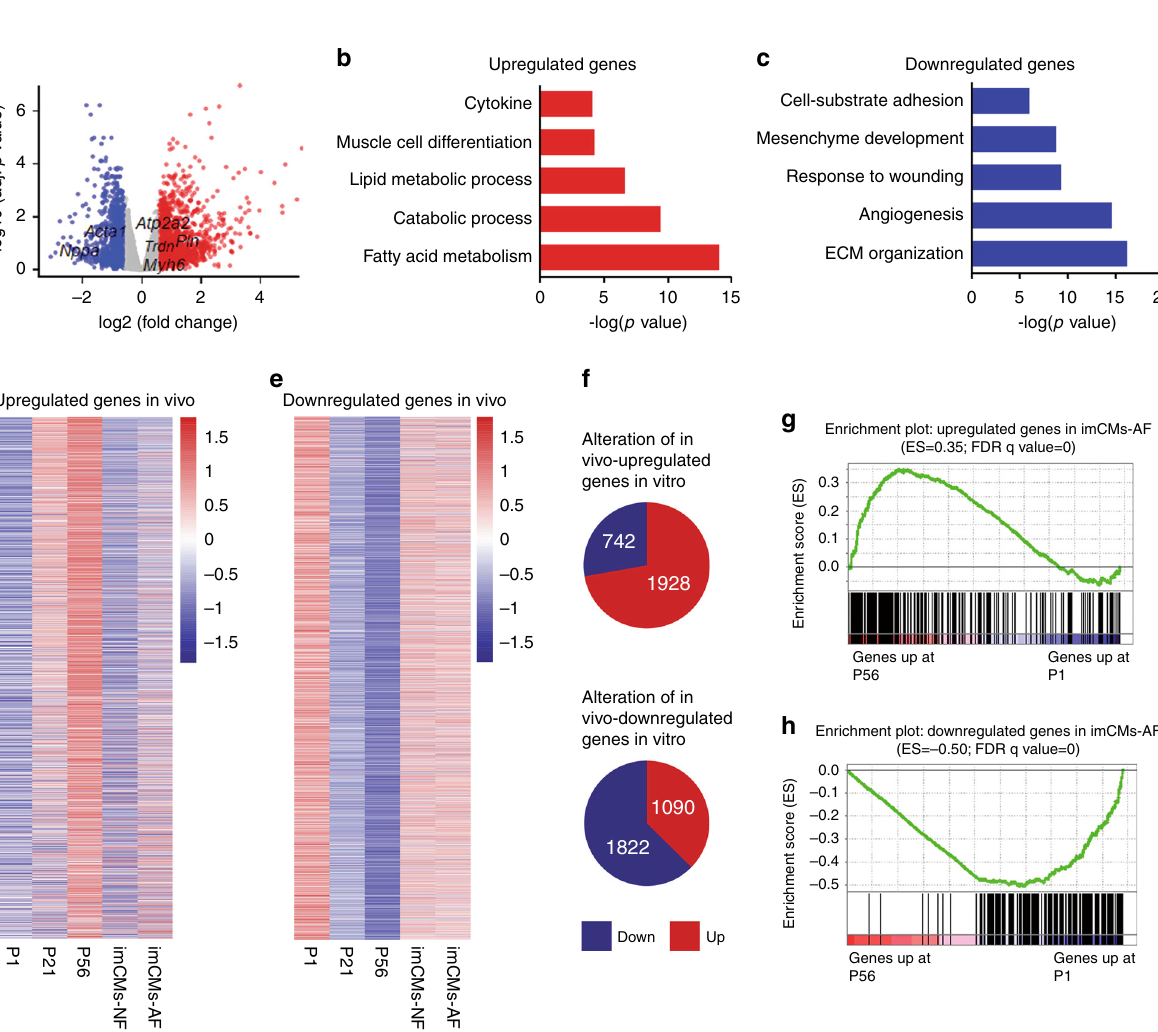
Fig. 5 Molecular similarities of in vitro and in vivo CM maturation. a Volcano plot to show DEGs in imCMs 3.5 days after co-cultured with NFs or AFs. Red indicates upregulated genes, and blue represents downregulated genes upon AF co-culture compared to imCM-NF (Supplementary Data 25). b , c Gene ontology analyses of upregulated ( b ) or downregulated ( c ) genes from a . Selected top categories are shown. d , e Heatmaps to show the expression of upregulated ( d ) or downregulated ( e ) genes during postnatal heart maturation in imCMs co-cultured with NFs vs. AFs. Please see Supplementary Data 26 for the full list. f Top: number of genes upregulated or downregulated in vitro among upregulated genes in vivo ( d ); bottom: Number of genes upregulated or downregulated in vitro among downregulated genes in vivo ( e ). g Gene Set Enrichment Analysis (GSEA) showing that genes upregulated upon AF co-culture were enriched for genes that were highly expressed in P56 vs. P1 CMs. h Gene Set Enrichment Analysis (GSEA) showing that genes downregulated upon AF co-culture were enriched for genes that were highly expressed in P1 vs. P56